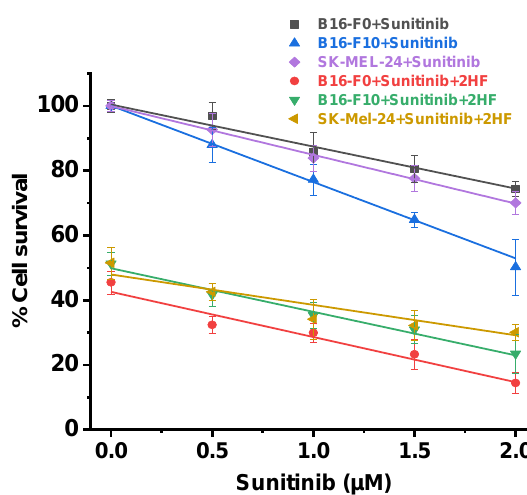
Figure 6. Mouse and human melanoma cell survival following sunitinib treatment with and without concomitant 2HF. Drug sensitivity assays were performed by MTT assay using 2HF at 72 h post-treatment to determine IC 50 . Cell proliferation assays were performed following sunitinib or 40 µM 2HF +